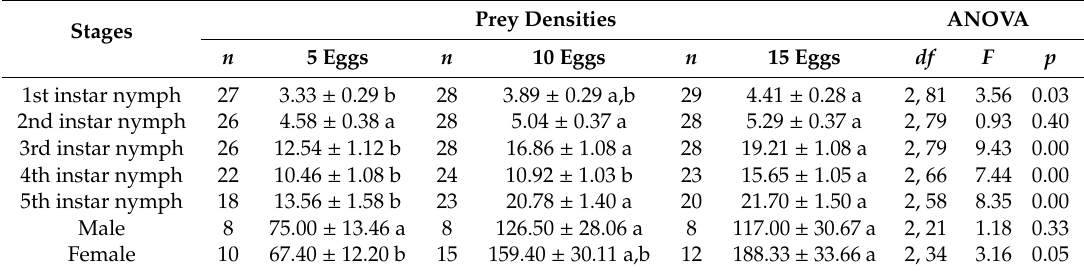
Table 1. Total feeding of O. strigicollis on Pectinophora gossypiella